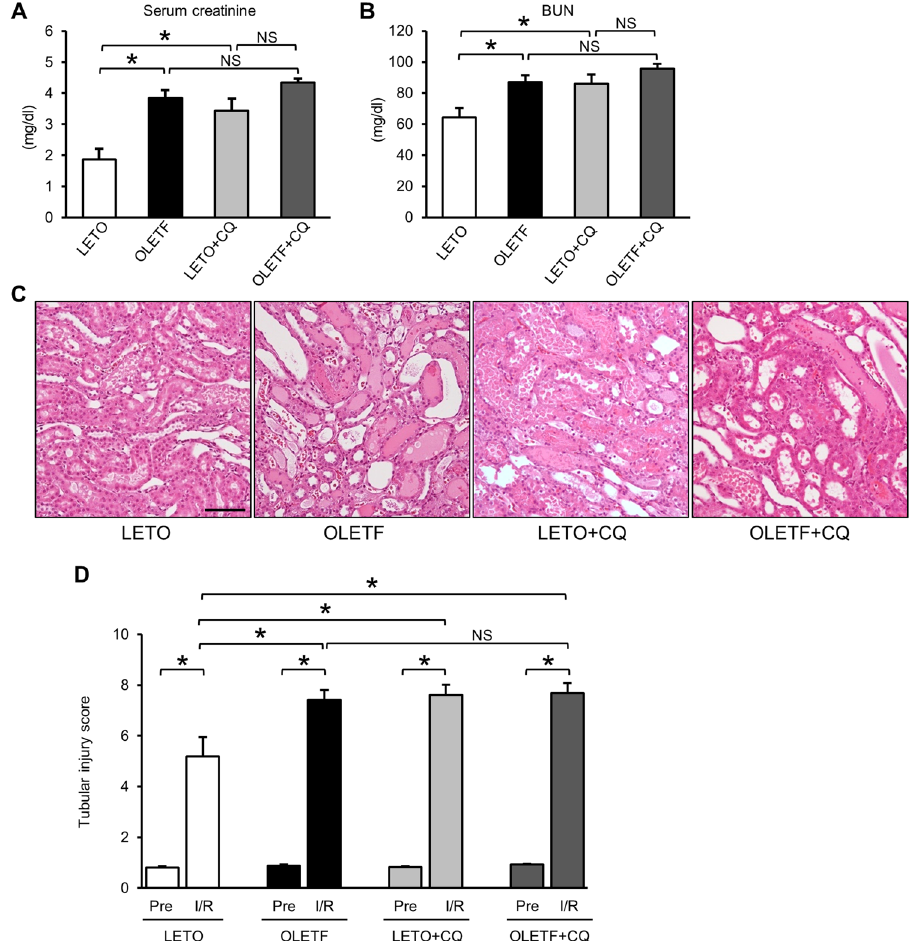
Figure 1. Type 2 diabetes and chloroquine increased susceptibility of the kidney to ischemia/reperfusion injury. Serum creatinine ( A ) and blood urea nitrogen (BUN) ( B ) levels of LETO (N = 12), OLETF (N = 12), LETO treated with chloroquine (LETO + CQ, N = 8), and OLETF treated with chloroquine (OLETF + CQ, N = 10) at 24 h after ischemia and reperfusion. ( C ) Representative images of hematoxylin-eosin staining of renal tissues at 24 h after ischemia/reperfusion. ( D ) Tubular injury score of renal tissues of before ischemia (Pre) and 24 h after ischemia/reperfusion (I/R) in the four groups. * P < 0.05. Scale bar, 100 μ m. NS = not